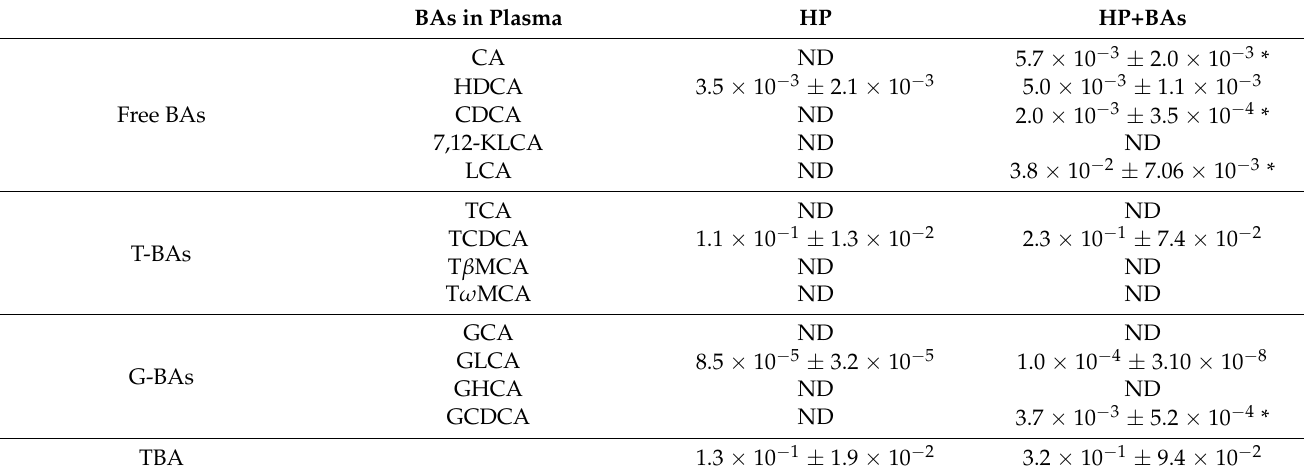
Table 5. Bile acid profile in plasma of common carp in HP and HP+BAs groups ( µ mol/L), CA, CDCA, LCA, and GCDCA increased observably in the HP+BAs group carp plasma. * Data are shown as mean ± SEM ( n = 7). Statistically significant results are indicated by asterisks (*, p <